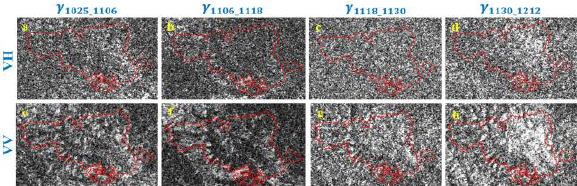
Figure 3. S1 paired coherence change maps with a red